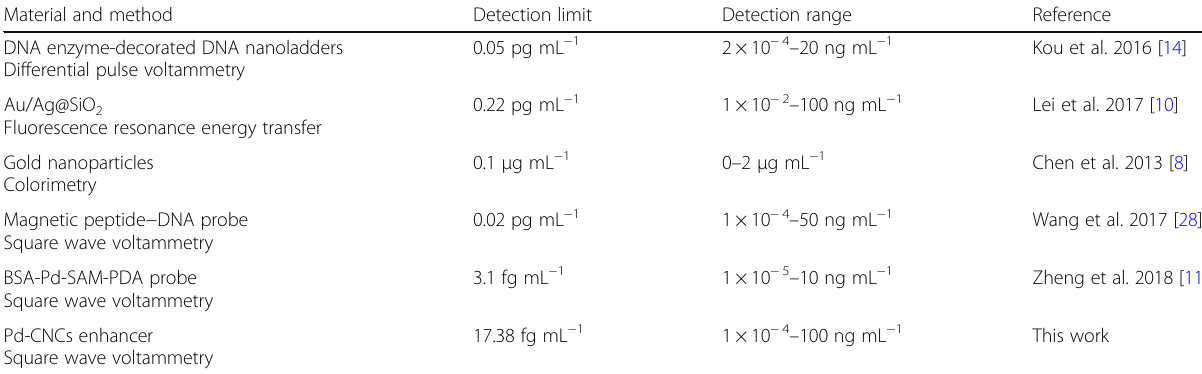
Table 1 Comparison of some recently reported biosensor for detection of MMP-7 Material and